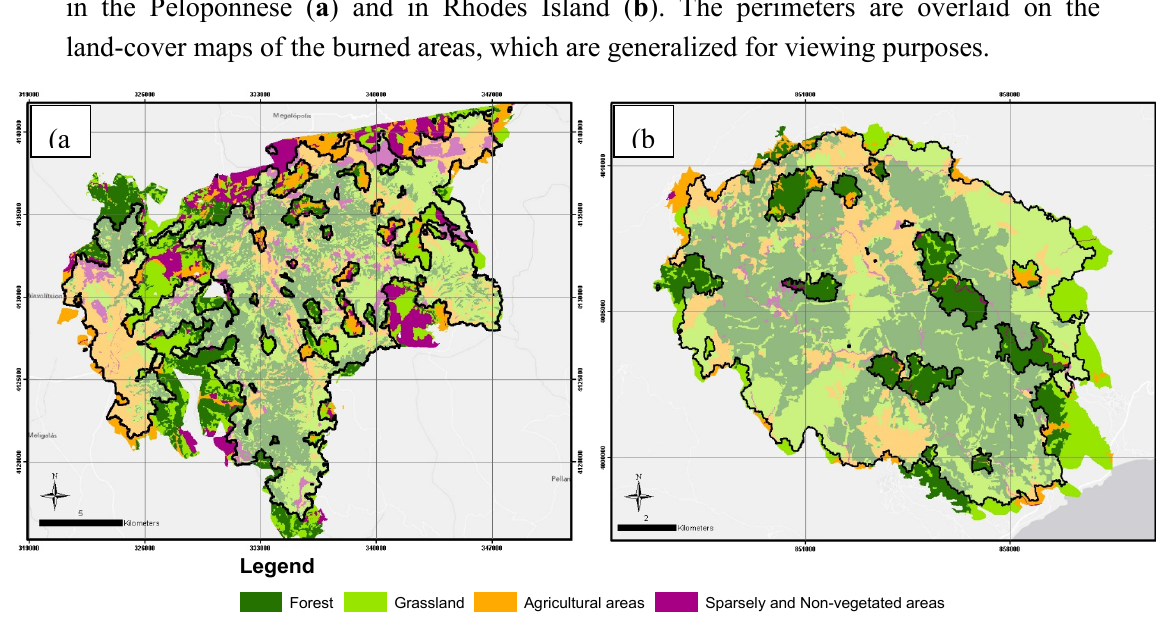
) and the probabilities of false d